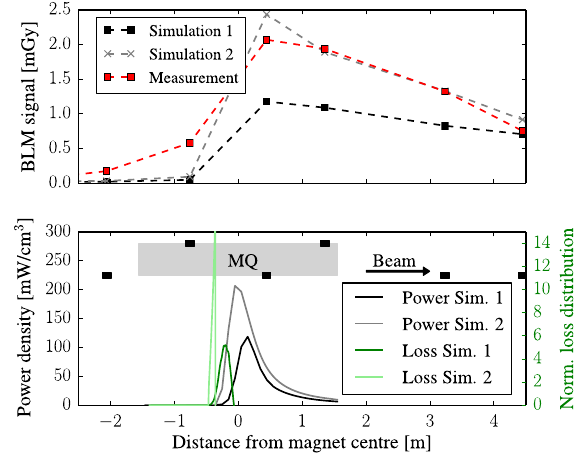
FIG. 22. Results of particle-tracking and particle-shower sim- ulations. Simulation 1 considers a smooth beam screen, whereas simulation 2 considers a 20-cm-long, 30- μ m-high aperture restriction close to the magnet center. Up: Detail of the com- parison between the BLM signal and the simulated signal from FLUKA for the static orbit-bump quench test. Down: FLUKA simulated peak energy density (black) deposited in the coils and MAD-X normalized distribution of protons lost on the beam screen (green). The gray box indicates the magnet, black boxes indicate the locations of BLMs.